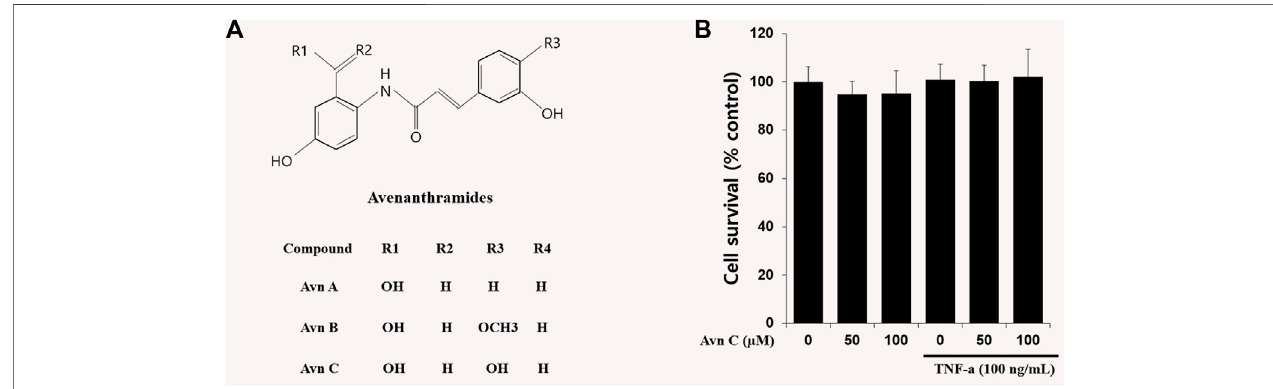
FIGURE1| ChemicalstructuresofAvenanthramidesandeffectsoncellviabilityinHASMCcells. (A) Avenanthramides:AvnA,AvnBandAvnC(Chemicalstructures) (B) Cell viability measured by MTT. 5 × 10 3 cell/well cells were treated with Avn C (0, 50, or 100 µM) and TNF- α (100 ng/ml) for 24 h.